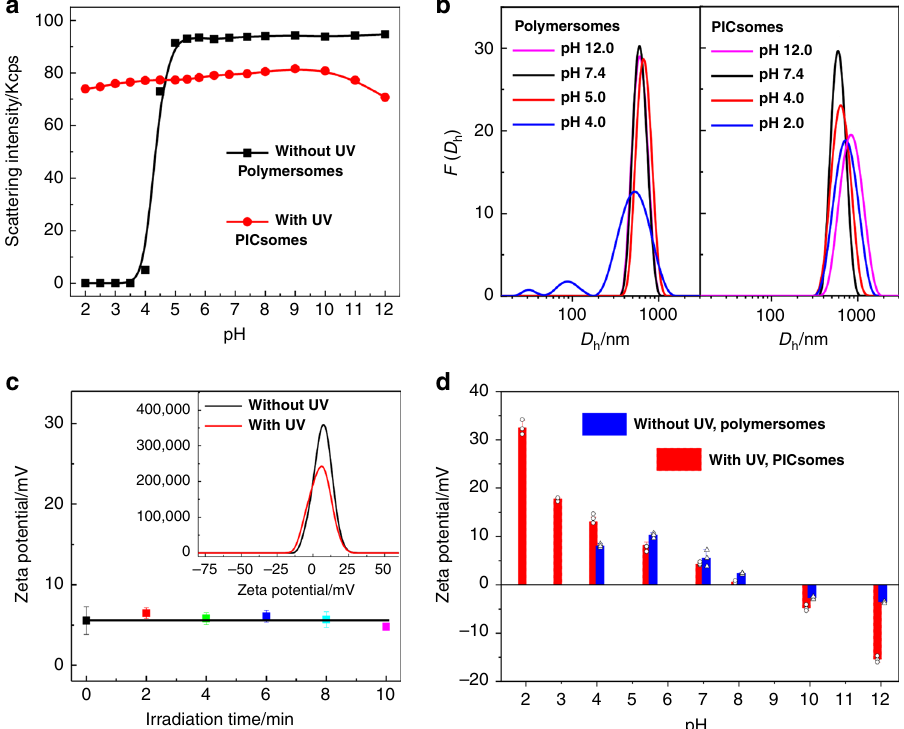
Fig. 6 Characterization of polymersomes and corresponding PICsomes. pH-dependent scattered light intensities a and intensity-average D h distributions b recorded for aqueous dispersions of PEO 45 - b -P(NCMA 0.55 - co -DPA 0.45 ) 29 polymersomes and PICsomes in the pH range of 2 – 12. c Irradiation duration- dependent evolution of zeta potentials during polymersome-to-PICsome transition in neutral aqueous media. d Variation of zeta potentials for aqueous dispersions of polymersomes and PICsomes in the pH range of 2 – 12. All data were obtained at a polymer concentration of 0.1 g/L with [NCMA] ~ 0.12 mM and [DPA] ~ 0.10 mM in Britton – Robinson buffer (pH 2 – 12, 12 mM; 25 °C). The error bars indicate standard deviation ( n =